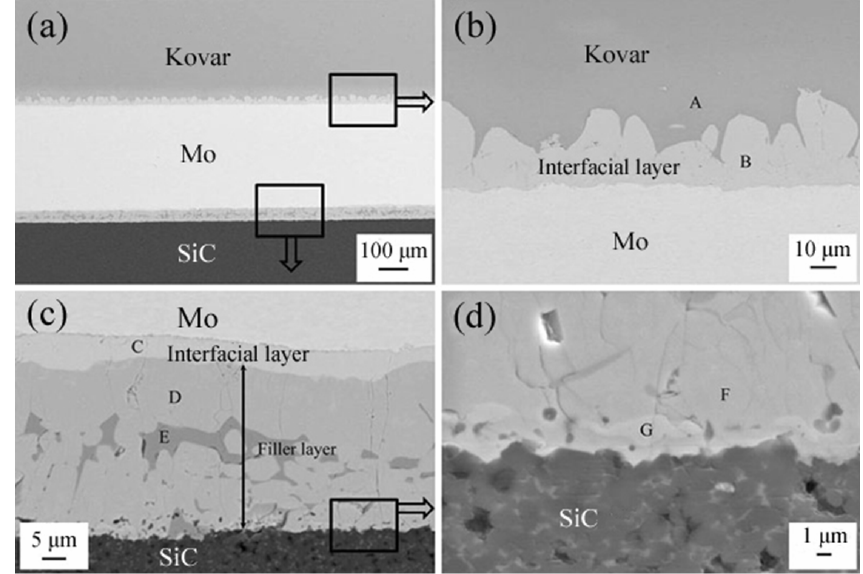
Fig. 8 Cross-sectional and interfacial microstructures of SiC/Kovar joints fabricated by composite joining (brazing+TLP bonding) method using Ni–Si/Mo interlayer: (a) Kovar/SiC joint, (b) Kovar/Mo interface, (c) Mo/Ni–Si/SiC section, (d) Ni– Si/SiC interface. Reproduced with permission from Ref. [75], © Springer Science+Business Media, LLC